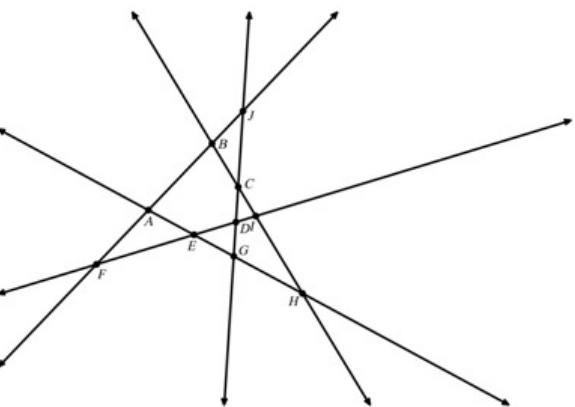
Figure 3. Intersecting lines generate X-junctions (i.e., all vertices have degree = 4). The convex polygons generated are primarily three- and four-sided, although much less frequently five-sided (here a polygon with vertices ABCDE exists with five edges). Note that no six-sided convex polygons are generated.